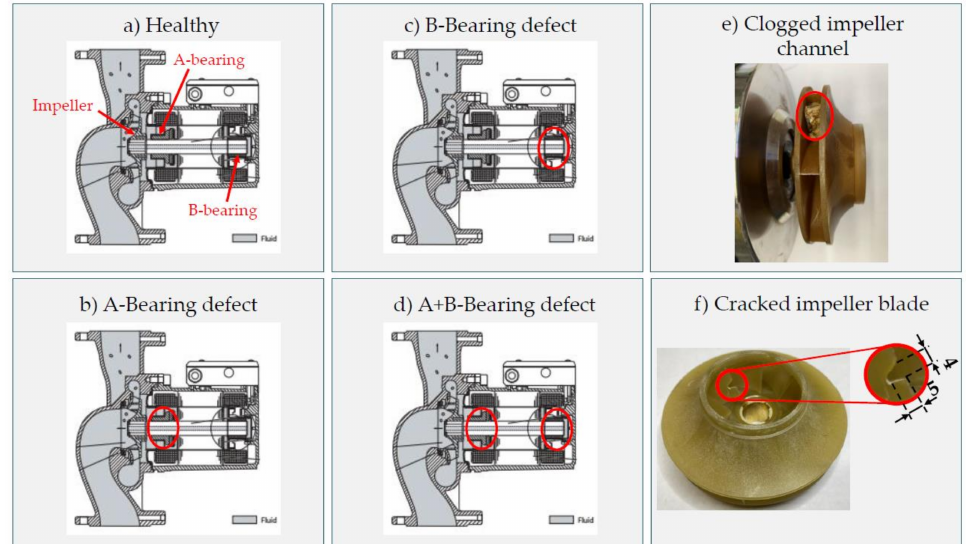
Figure 5. Investigated variants; ( a ) healthy; ( b ) A-bearing defect; ( c ) B-bearing defect; ( d ) A- + B- bearing defect; ( e ) clogged impeller channel; ( f ) cracked impeller blade; ( a – d )